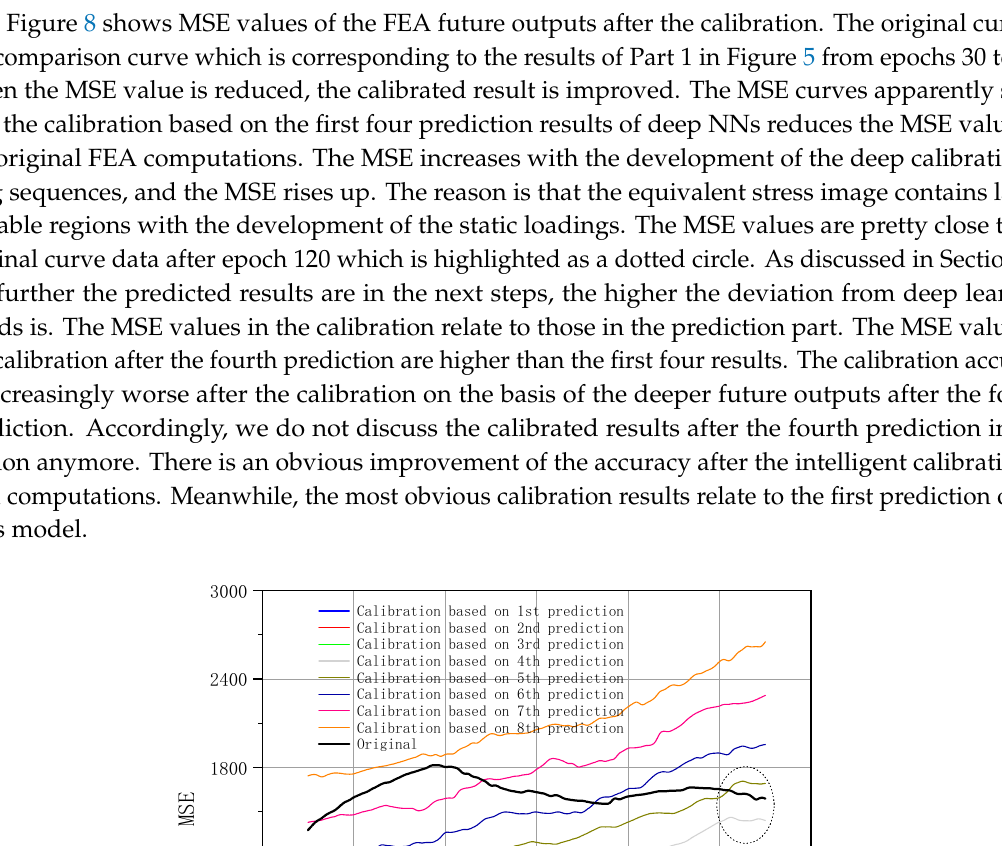
Figure 7. Histogram and frequency of image intensity.